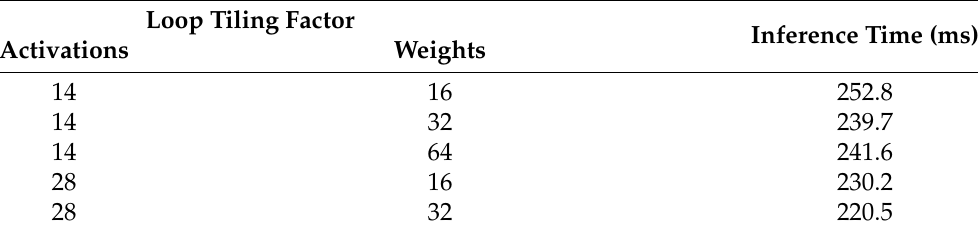
Table 3. Inference time with different loop tiling